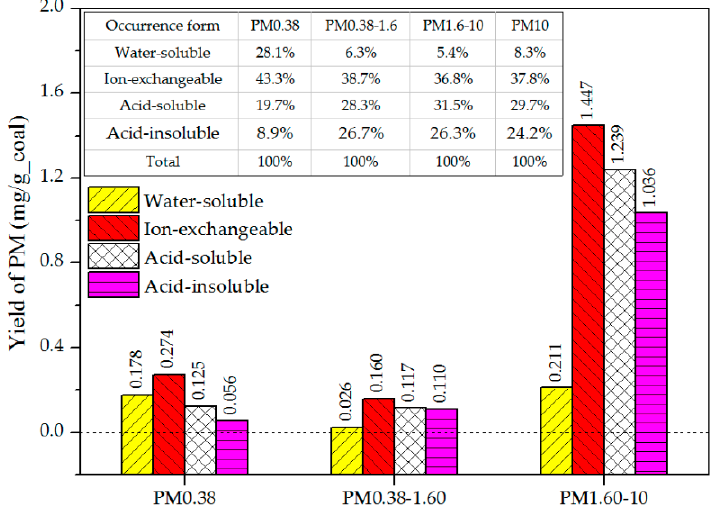
Figure 4. Yields and proportional contributions of the PM emitted from the four form minerals.